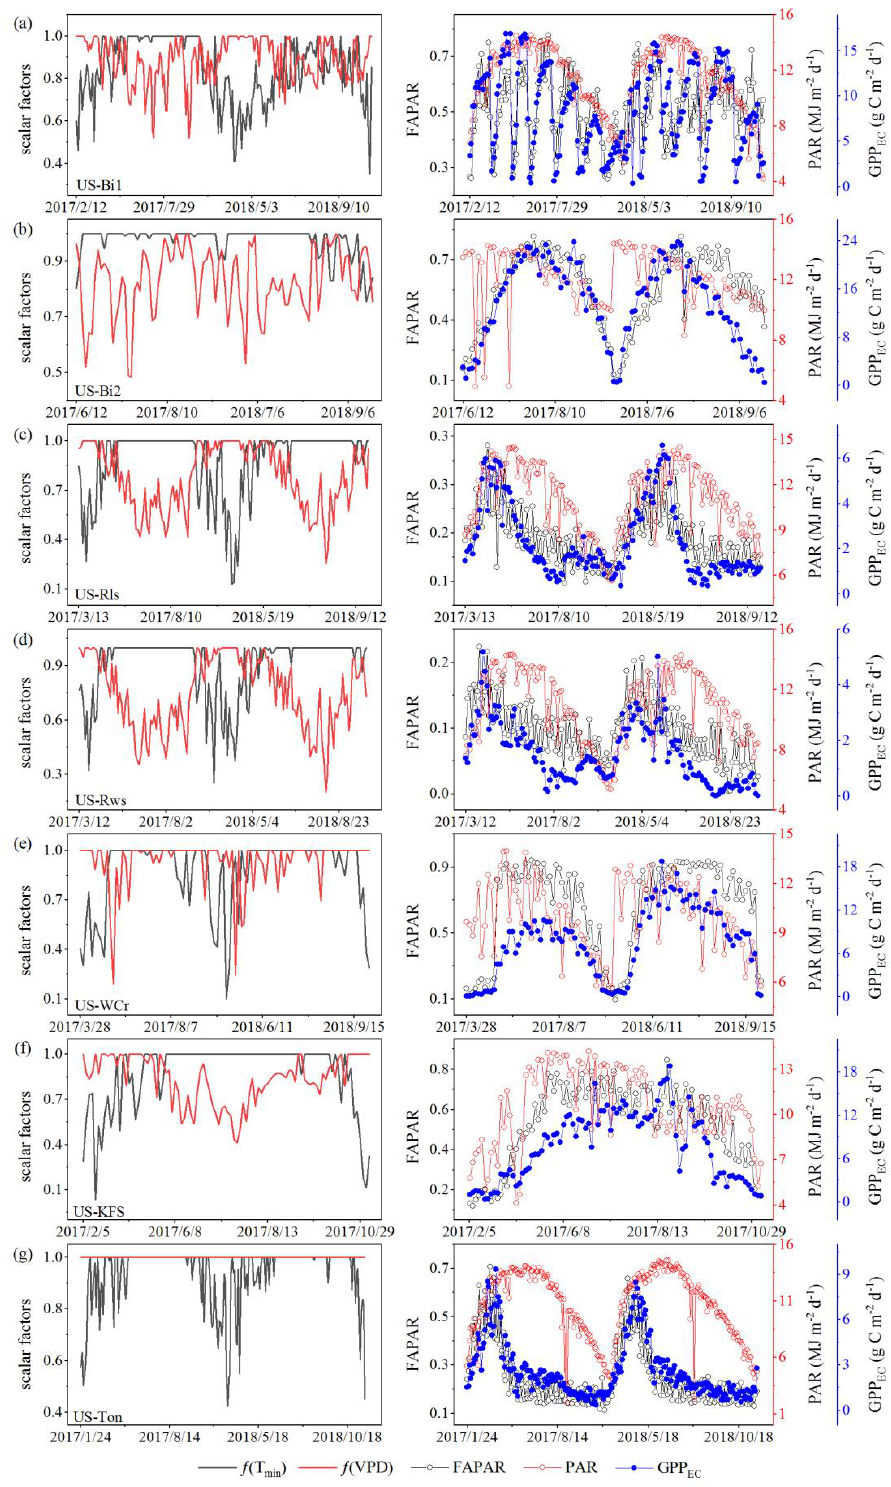
Figure 4. Temporal dynamics ofscalar factors (ƒ(T min ) and ƒ(VPD)) in the left column; fraction of absorbed photosynthetically active radiation (FAPAR), photosynthetically active radiation (PAR), and GPP EC in the right column for all seven sites in 2017 and 2018. ( a – g ) represent the sites the same as Figure